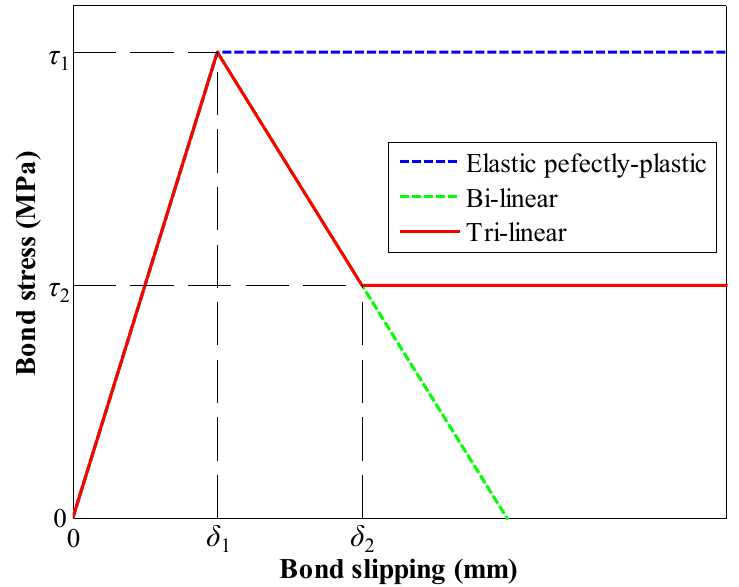
Figure 1. Tri-linear equation.